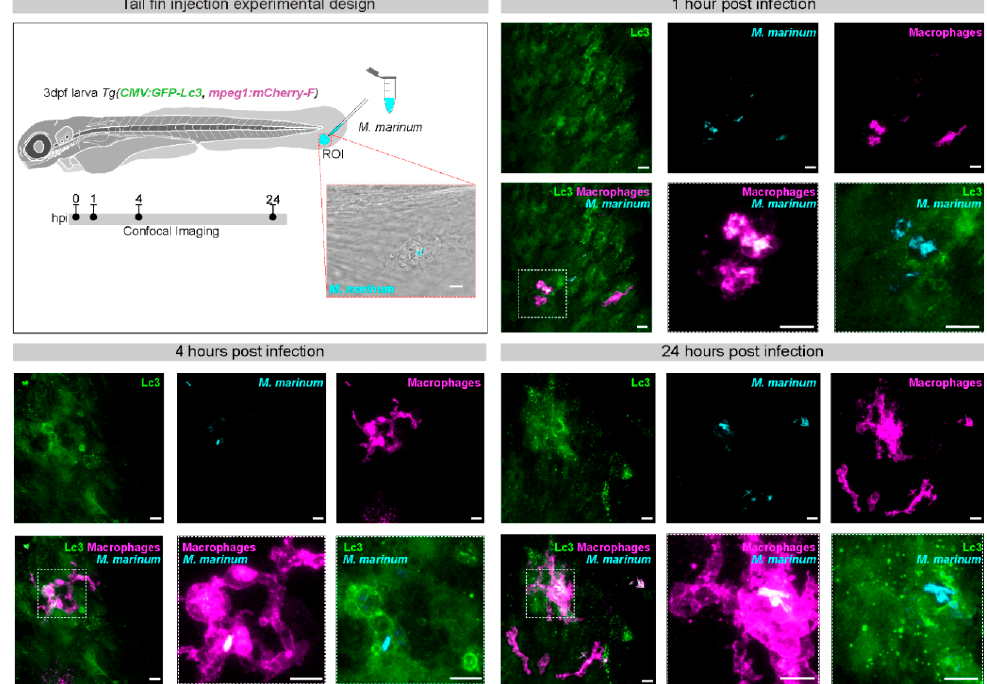
Figure 2. GFP-Lc3 response to M. marinum infection in the tail fin of zebrafish larvae. In the experimental setup of tail fin injections, mCrimson-labeled M. marinum bacteria (200 colony forming units) are microinjected into the tail fin area of zebrafish larvae at 3 days post fertilization (dpf), derived from a double transgenic line that contains a ubiquitously expressed CMV:GFP-Lc3 construct and an mpeg1:mCherry-F construct that labels macrophages. The injection site and region of imaging (ROI) is indicated in the schematic drawing of the larva and a representative bright field and fluorescence overlay image shows the infected area in the tail fin. Confocal laser-scanning microscopy images were acquired 1, 4, and 24 h post infection (hpi). Fluorescent excitation in the range of GFP, far-red and red were used to visualize GFP-Lc3, M. marinum, and macrophages, respectively. At 1 hpi, macrophages are already recruited at the site of infection and phagocytosis of bacteria can be observed. At 4 hpi, GFP-Lc3 signal is observed inside infected macrophages and often appears in ring- shaped patterns. At 24 hpi, the bacterial cluster sizes and numbers are increased, both intra- and extracellularly, which is associated with strong punctate GFP-Lc3 signal in the infected tissue. The boxed areas in the representative images of the different time points are shown in detail on the right. Scale bars: 10 μ m.